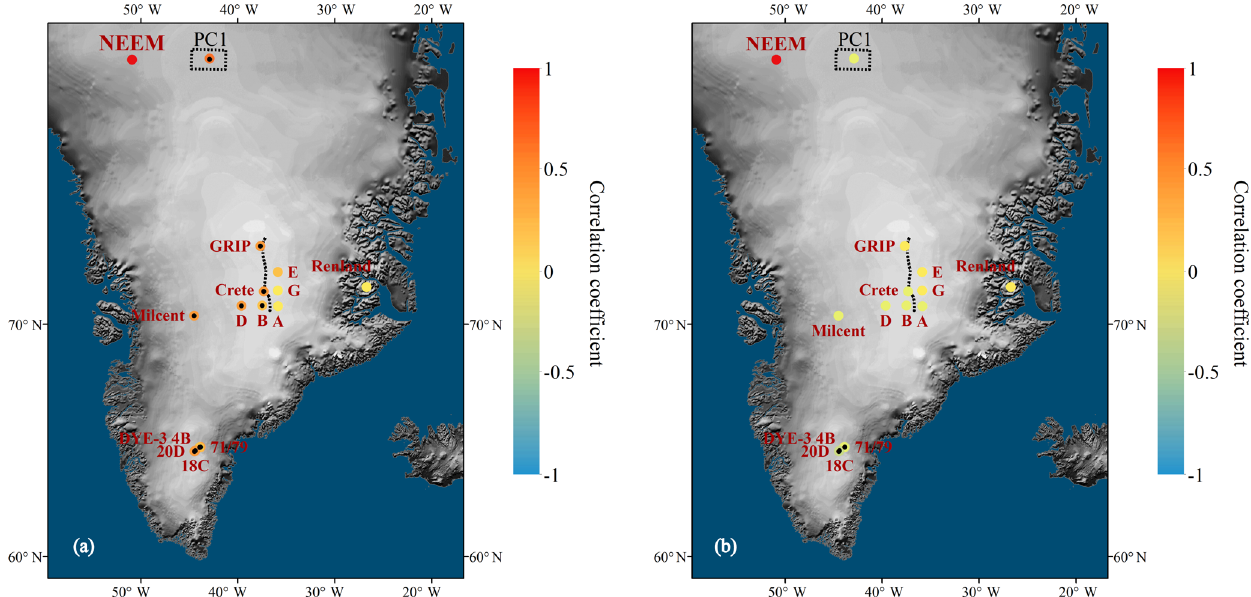
Figure 3. Correlation coefficients between NEEM seasonal δ 18 O and Greenland seasonal δ 18 O records for the period 1855–1970 ( a for summer and b for winter). The PC1 of seasonal central/southern Greenland δ 18 O records is shown within the black dashed rectangle. The ice divide is marked by dotted black line. The significant correlations at the 95% confidence level are filled with a black dot ( t test).